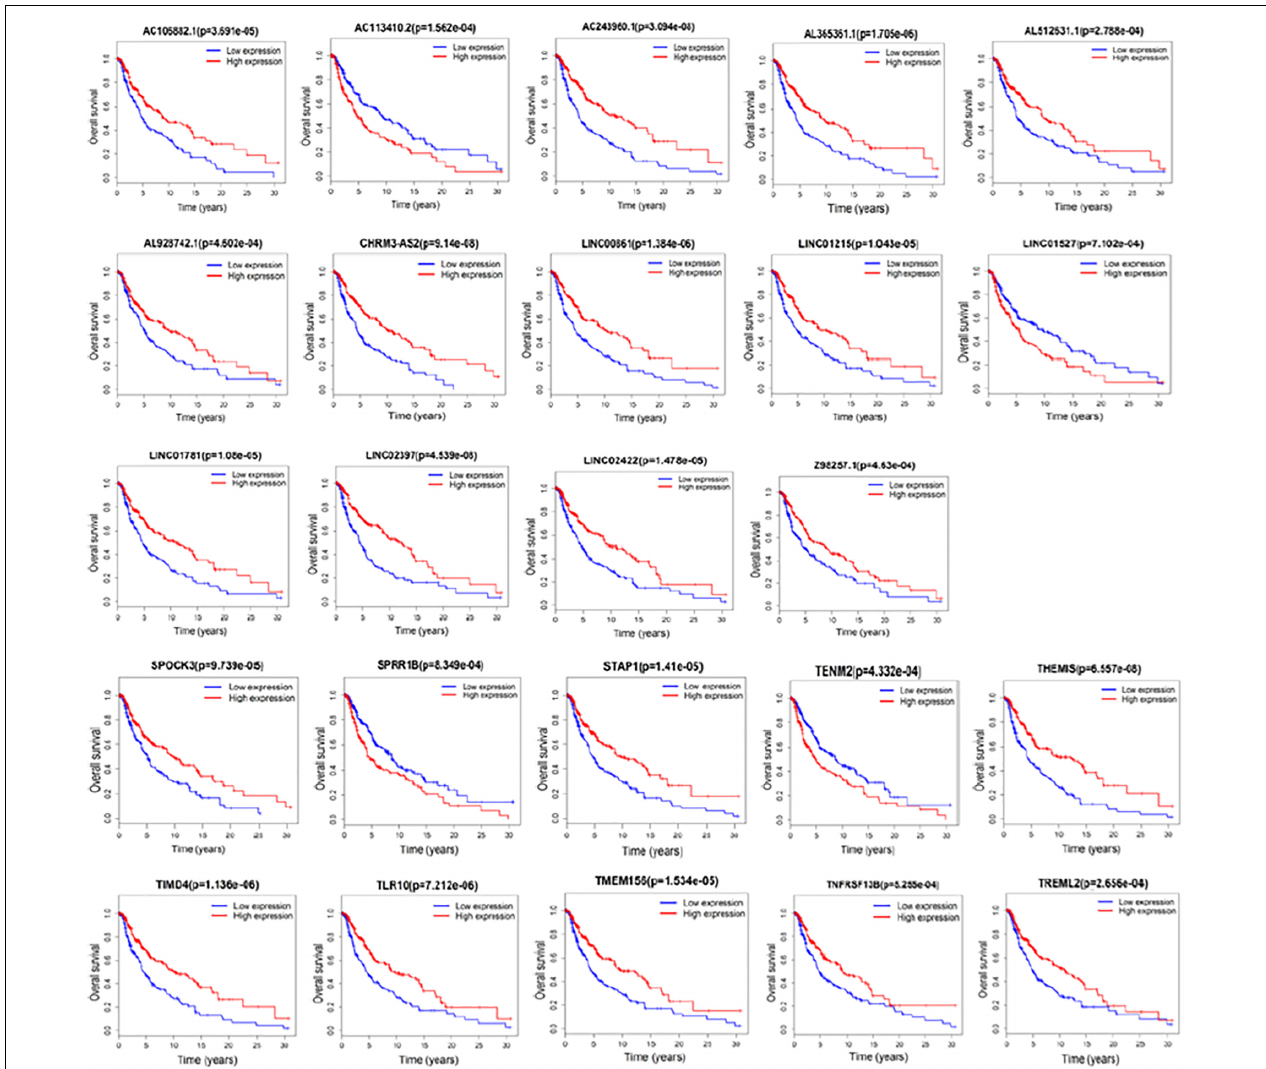
FIGURE 5 | Kaplan–Meier analysis for overall survival rate of patients from TCGA. Log-rank test was performed to evaluate the survival differences between the two curves ( p < 0.001). Overall survival rate for 14 lncRNAs and 10 mRNAs were identified